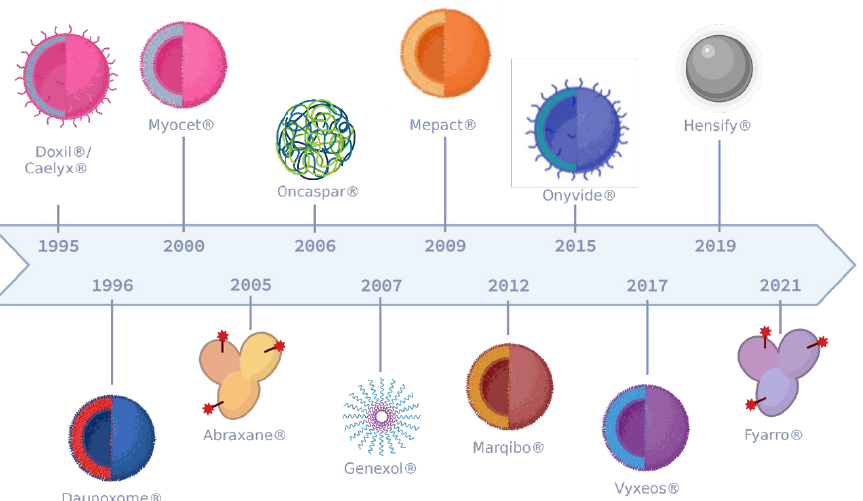
Figure 1. Timeline of the marketing authorization of the keystone cancer nanotherapeutics. In 1995, Doxil® /Caelyx® was the first FDA-approved (pegylated) liposome, followed by unpegylated lipo- somes; Daunoxome® , Myocet® , Mepact® , Marqibo® , and Vyxeos® and pegylated one: Onyvide® . Vyxeos is the first commercialized nanotherapeutics encapsulating two chemotherapies (i.e., cytar- abine and daunorubicin). Other formulations have been approved in the clinic, such as nab-drugs in 2005 and 2021 (i.e., Abraxane® and Fyarro® , respectively), pegylated aparaginase (i.e., Oncas- par®) in 2006, polymeric micelles (i.e., Genexol® ) in 2007, and inorganic nanoparticles in 2019 (i.e., Hensify® ). Table 1. Anticancer nanomedicine currently approved by the FDA and/or EMA. Adapted from An- selmo et al. [5]. Of note: ADCs will be developed in Table 2.